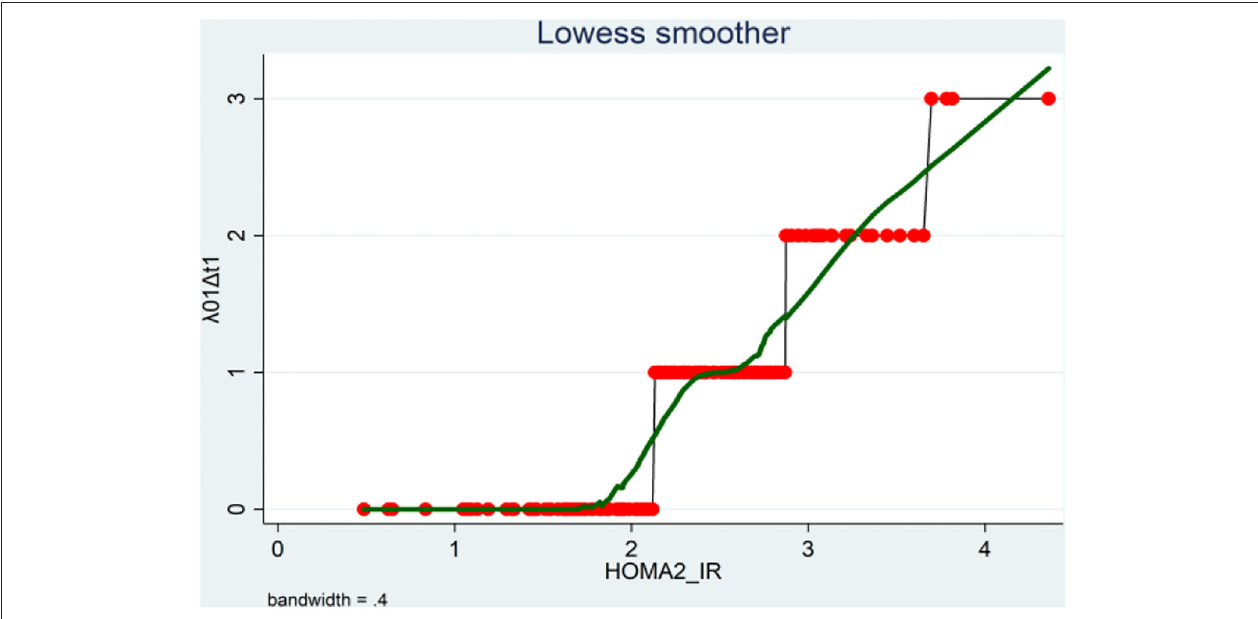
FIGURE 4 | Lowess smoother showing the non-linear relationship between the transition counts from F0 to F1 and the HOMA2-IR